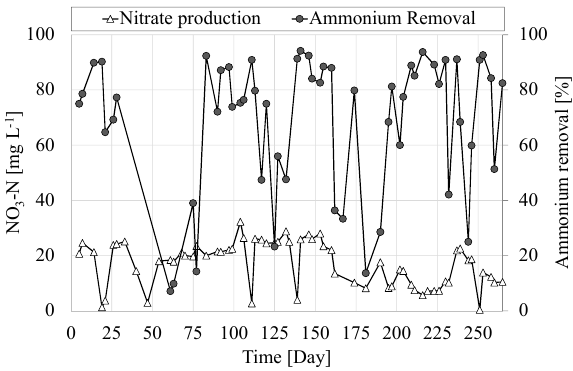
Figure 6. Nitrate production and ammonium removal efficiency throughout experiments.